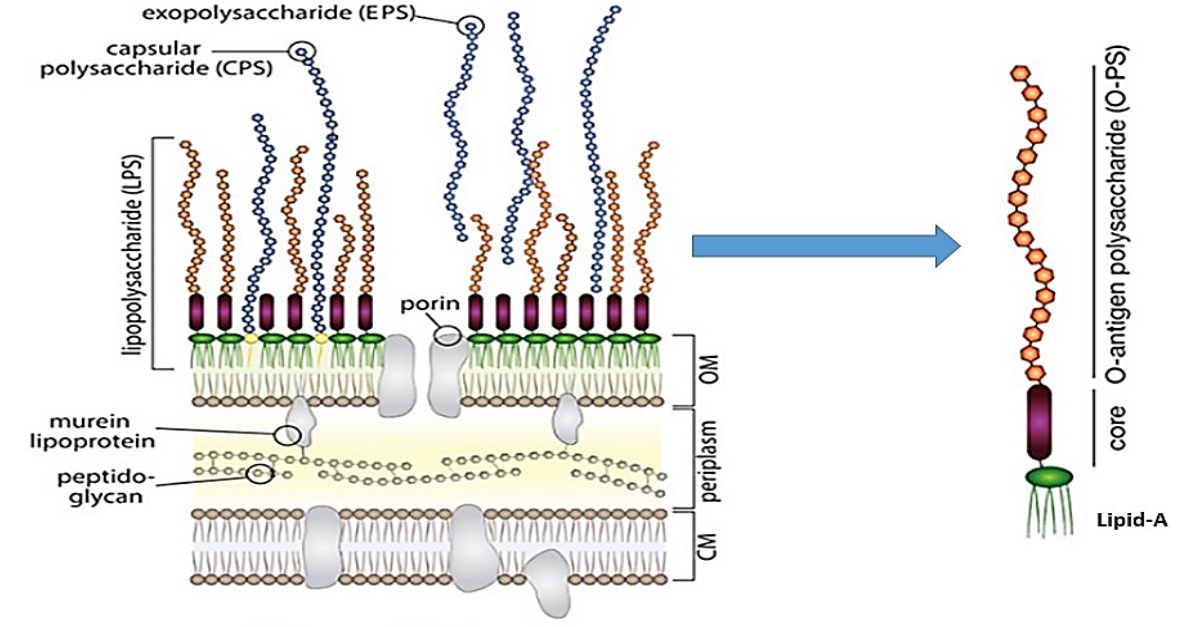
Figure 9. Conceptual organization of the cell envelopes of Gram-negative bacteria. An outer leaflet of the asymmetric OM is composed of LPS essential for the permeability barrier’s integrity. LPS structure (blue arrow) is composed of lipid A and core oligosaccharides capped with a long O-antigen polysaccharide chain. The bacteria are covered in a CPS layer; at times, this CPS is released from the cell in large amounts as free EPS. Adapted with permission from [128]. Copyright © 2022, The Consortium of Glycobiology Editors, La Jolla, California.